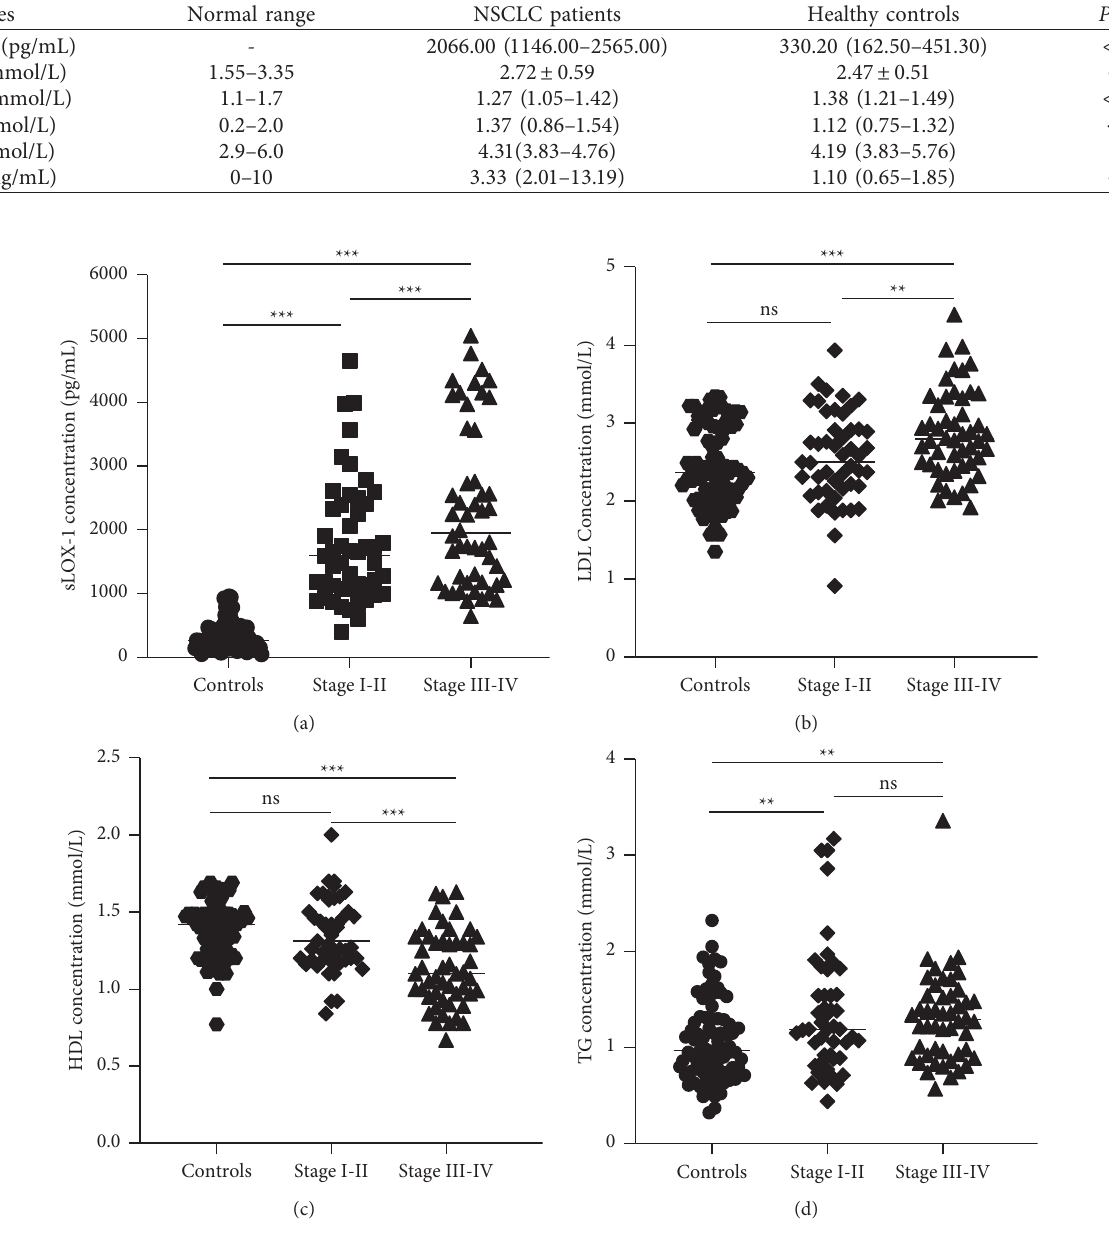
Figure 1: Expression levels of sLOX-1, LDL, HDL, and TG in serum of patients with NSCLC stage I–II and stage III–IV. ns: no significance. ∗∗ p < 0.01. ∗∗∗ p < 0.001. Table 3: Correlation of serum sLOX-1 with blood lipid indexes and